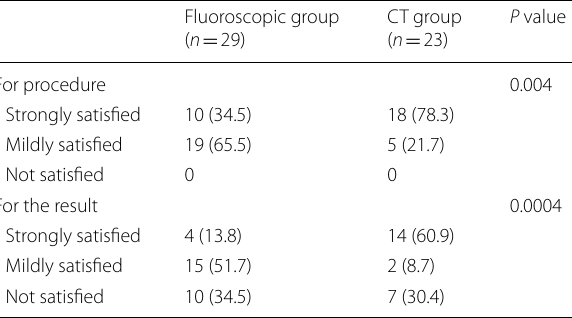
Data are number of patients. Data in parentheses are percentages.